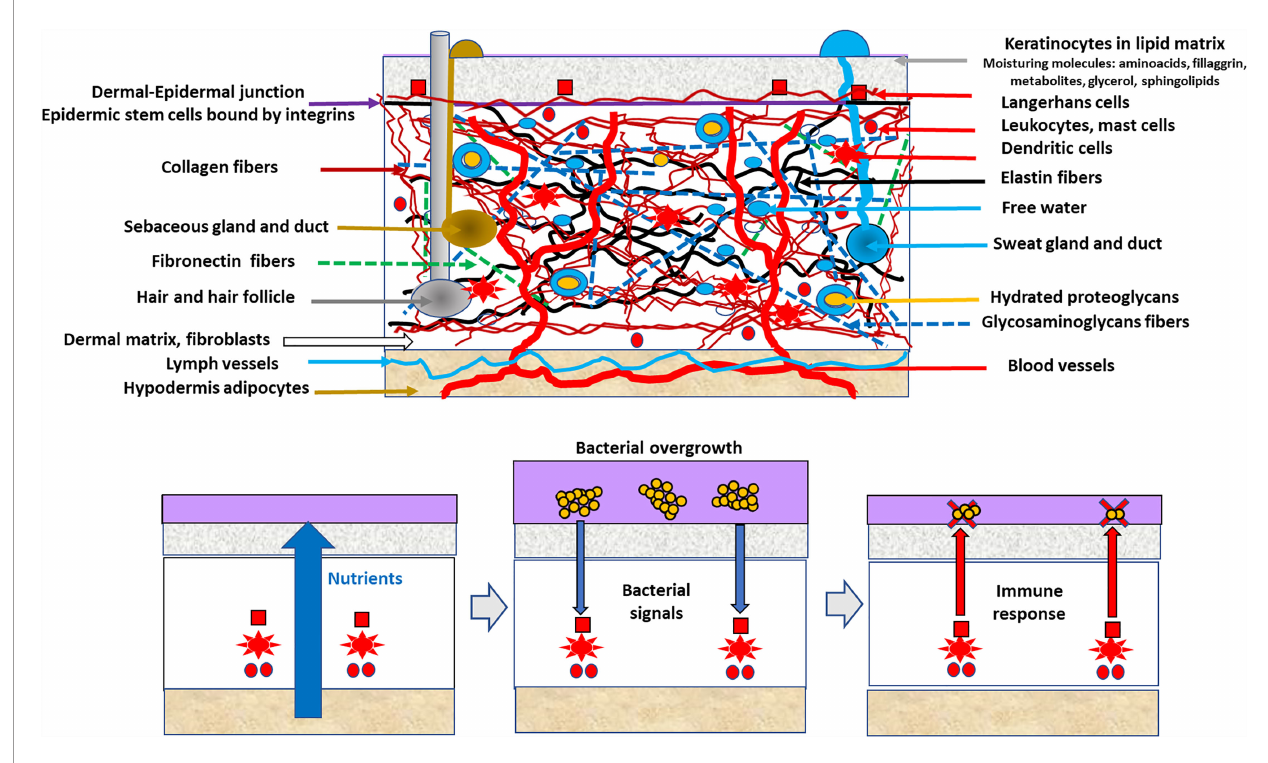
FIGURE 1 | The hypothesis of indirect epidermal bacterial clearance of a pathogen. Up in the fi gure, a schematic view of the skin is presented, particularly of the components of the dermal compartment, determining the commensal microbiota of the epidermis. Below, the indirect epidermal bacterial clearance of a pathogen (clusters of yellow circles) in the violet layer (surface commensal microbiota). Conditions facilitating the growth of commensals (vertical blue thick arrow) also favors pathogens, but the commensals overgrowth stimulate (narrow blue arrows) the defense system based on cellular local immune innate response involving cellular (red squares, circles, stars) and glands secretion. Antimicrobial defense (red arrows) reduces the overall bacterial density, but the lower-numbered pathogens are eliminated (red X symbol), whereas the dominant commensal population is reduced to its normal density (sequence from the second to the third box at the